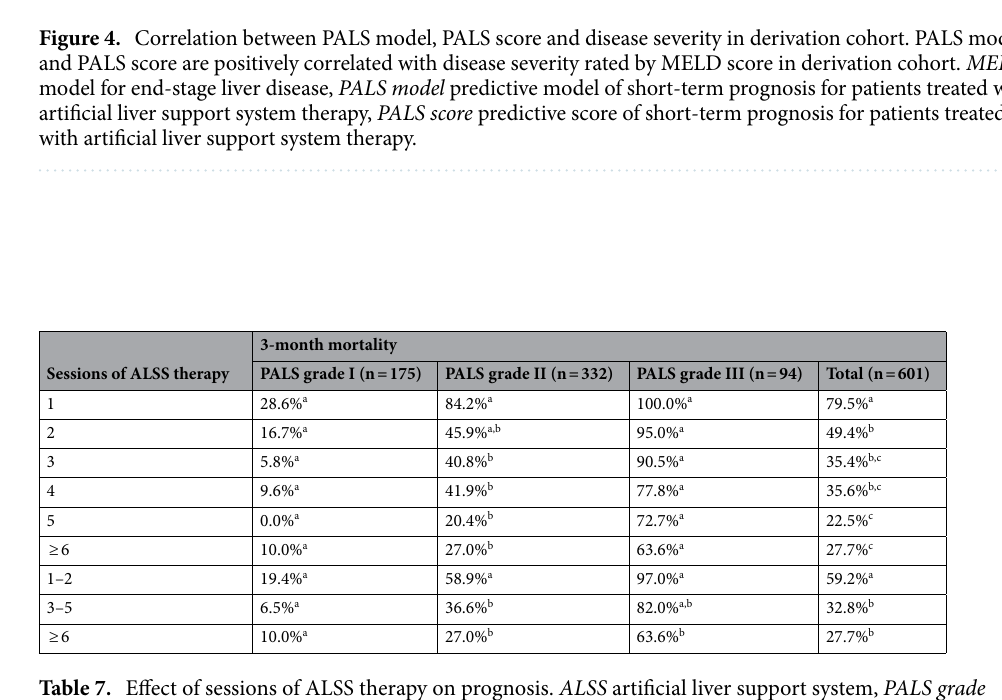
Table 7. Effect of sessions of ALSS therapy on prognosis. ALSS artificial liver support system, PALS grade grade of PLAS score, PALS score predictive score of short-term prognosis for patients treated with artificial liver support system therapy. Each superscript letter denotes a subset of PALS Grade categories whose column proportions do not differ significantly from each other at the 0.05 level.